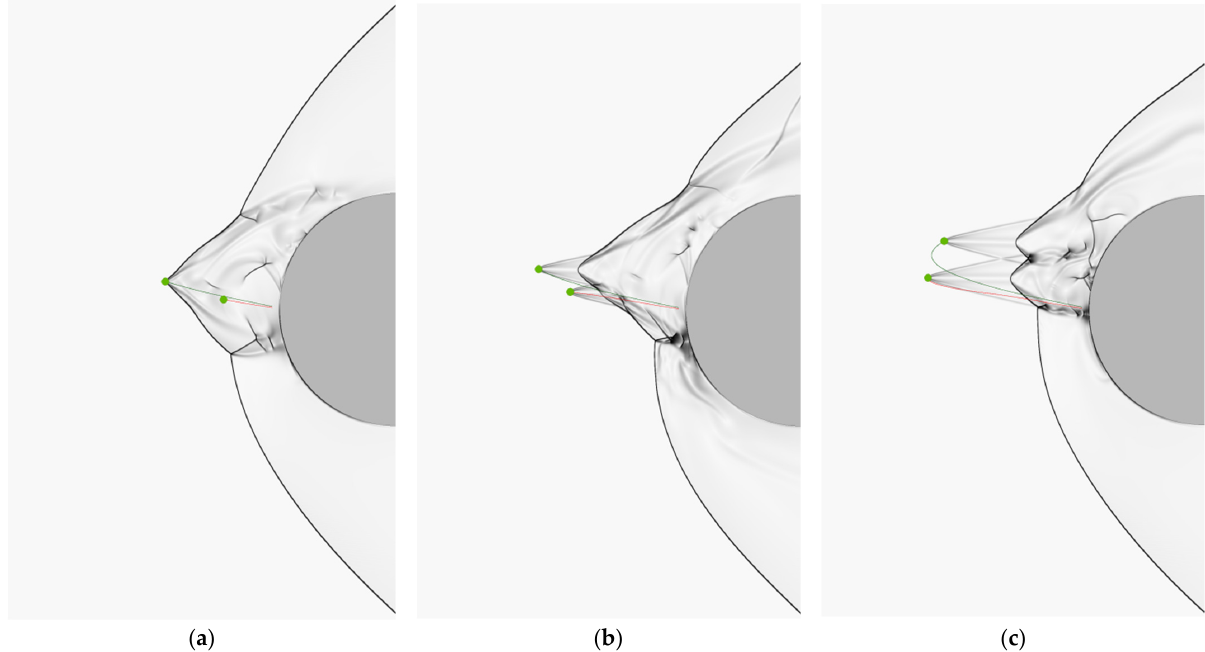
Figure 6. Schlieren images at successive times. ( a )—0.3 ms, ( b )—0.47 ms, ( c )—0.87 ms. Variant 1 with two particles.